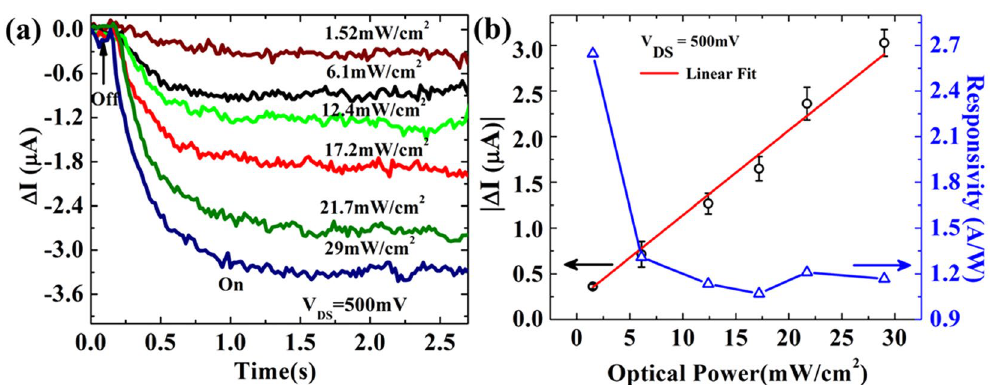
Figure 2. Power dependence for 1064 nm NIR light. ( a ) A set of time dependent change-in-current ( Δ I ) curves measured with different optical power density (1.52 mW/cm 2 –29 mW/cm 2 ) at V DS = 500 mV ( b ) Variation of change-in-current ( Δ I ) and responsivity with optical power densities. The black circles represent the extracted Δ I with respect to different power densities and the same is fitted linearly as shown by the red